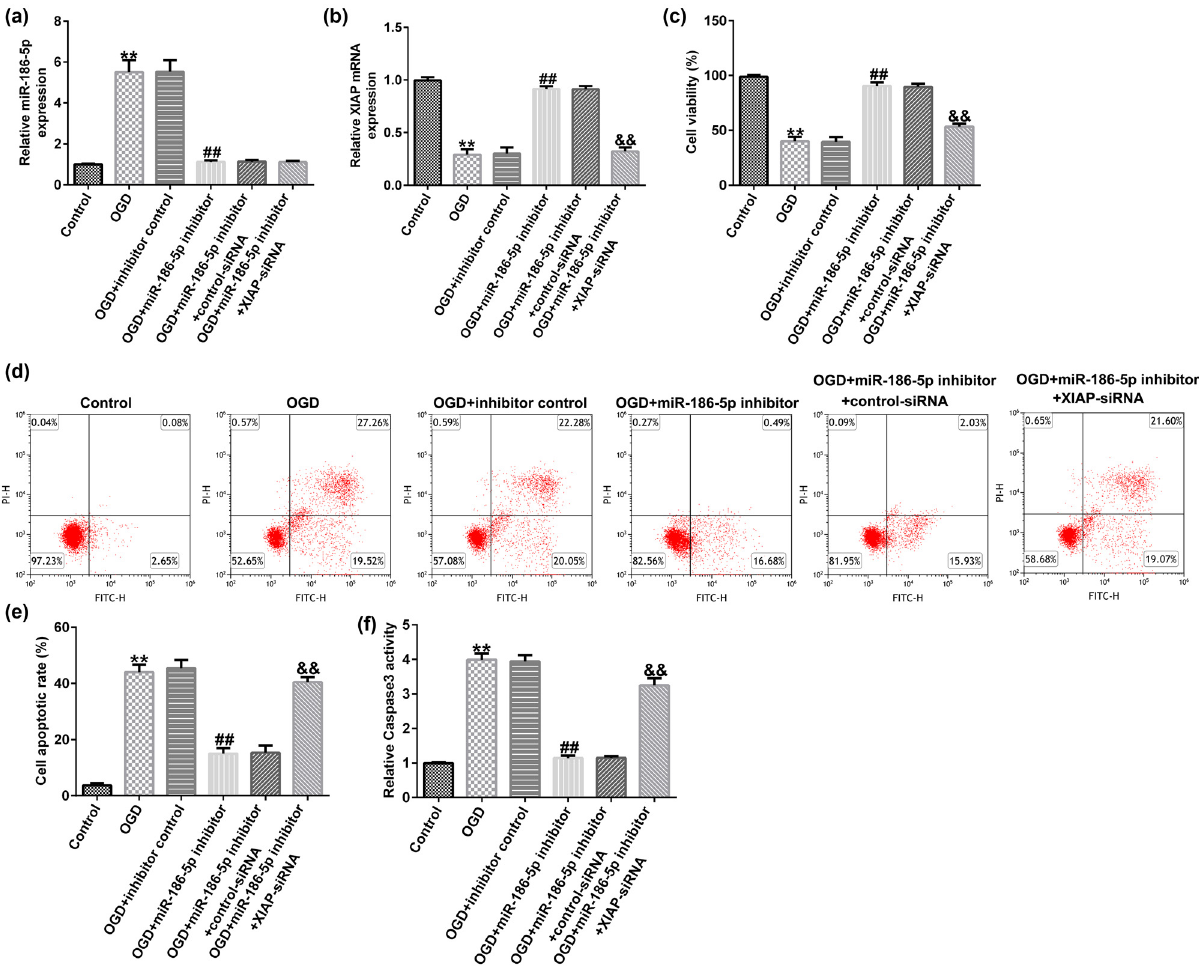
Figure 7: miR - 186 - 5p inhibitor attenuates OGD - induced neuronal injury by upregulating XIAP expression. ( a ) RT - qPCR analysis results showing miR - 186 - 5p expression levels. ( b ) RT - qPCR analysis results showing XIAP expression levels. ( c ) MTT assay was used to assess the cell viability. ( d ) Flow cytometric assay was carried out to evaluate cell apoptosis. ( e ) The cell apoptosis ratio is presented. ( f ) Caspase 3 activity was detected using the corresponding kit. ** P < 0.01 vs control group; ## P < 0.01 vs OGD + inhibitor control group; && P < 0.01 vs OGD + miR - 186 - 5p inhibitor + control siRNA group. GraphPad Prism 6.0 software ( GraphPad Software, Inc. ) was used for creation of the fi